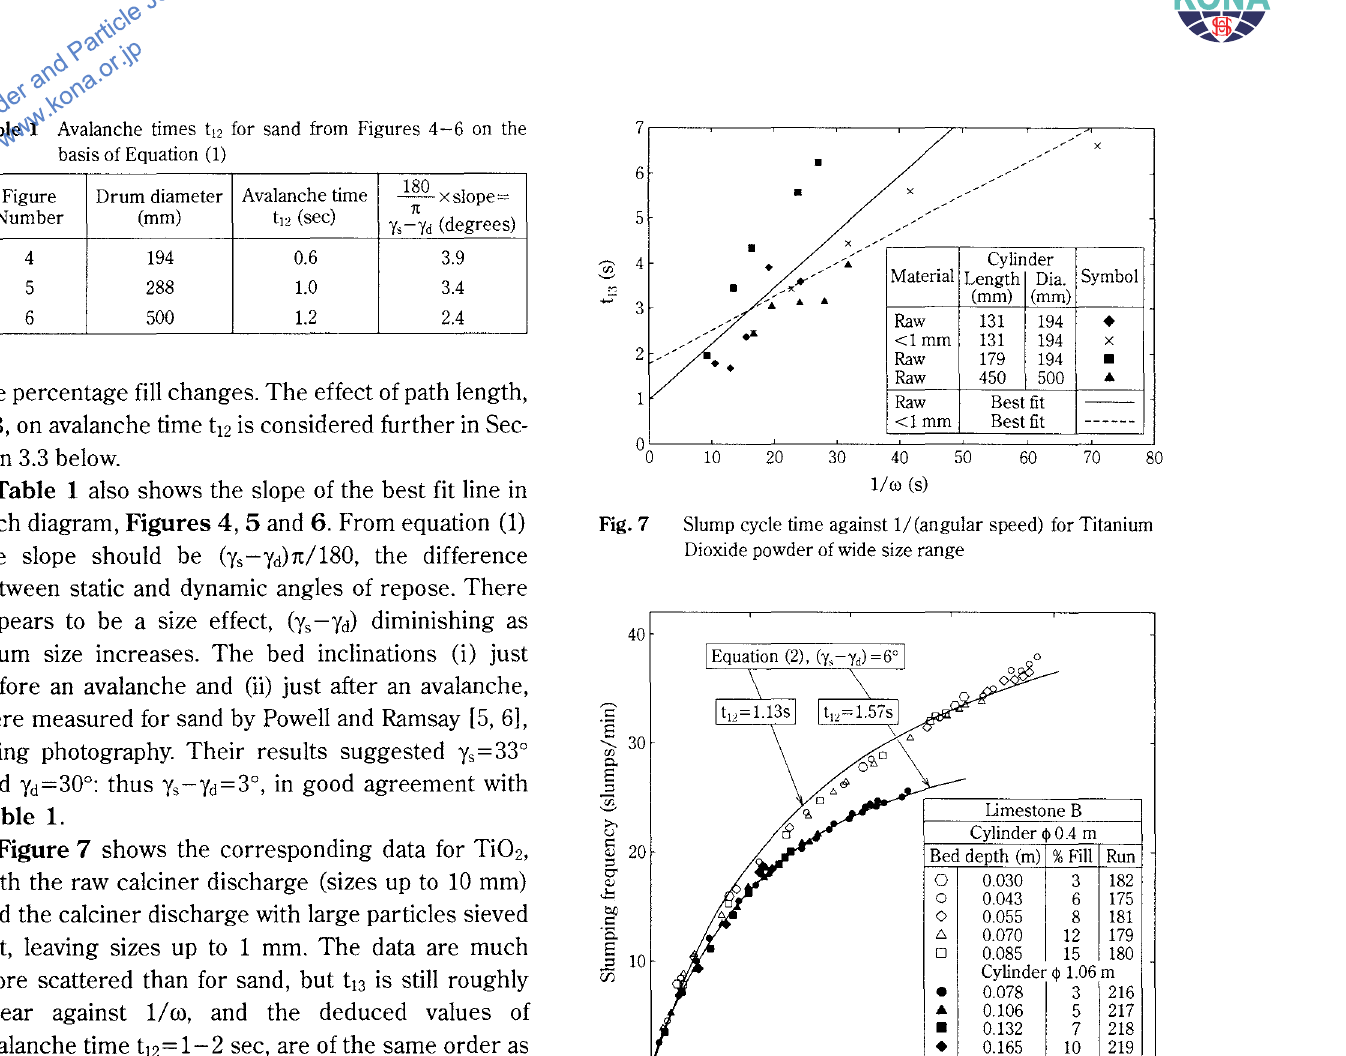
Fig. 8 Slumping frequency data of Henein eta! [1]. The curves are from Equation (2) with (y,-yiJ and t 12 chosen to give best fit to the